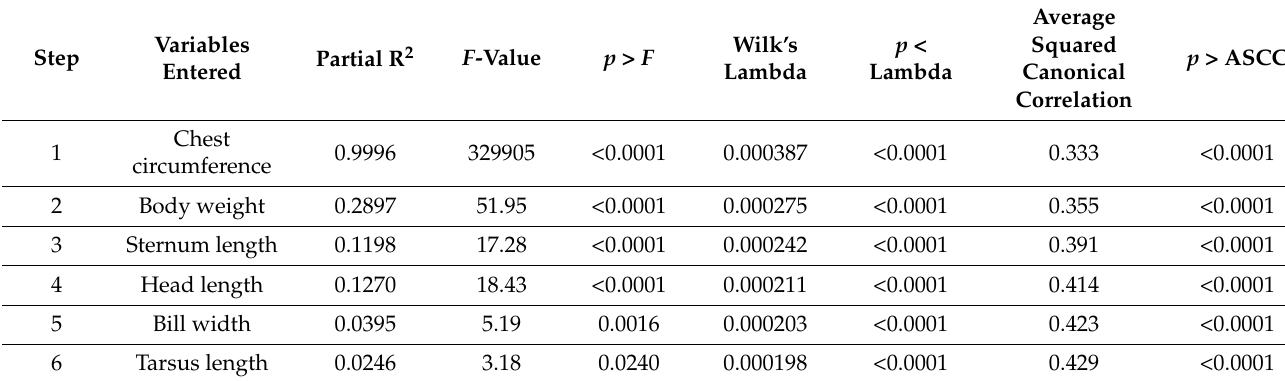
Table 3. Summary of the stepwise selection of